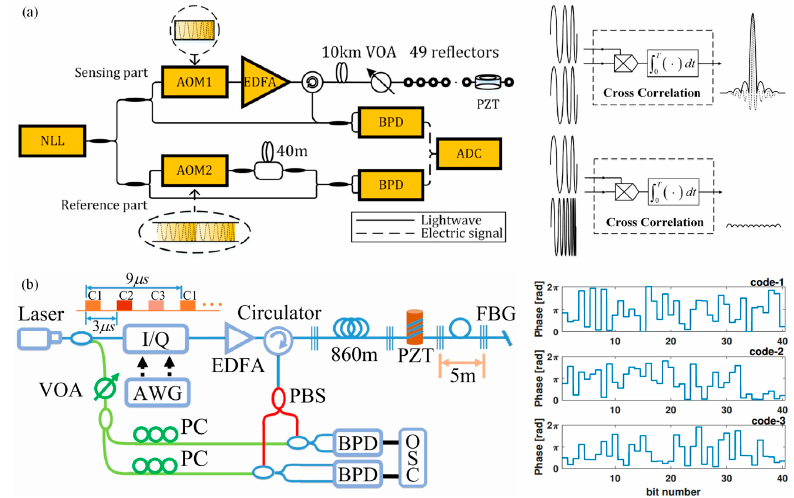
Figure 14. Representative scheme for pulse width compression: ( a ) orthogonal polarization scheme [70,71]; ( b ) multi-parameter scheme [72].